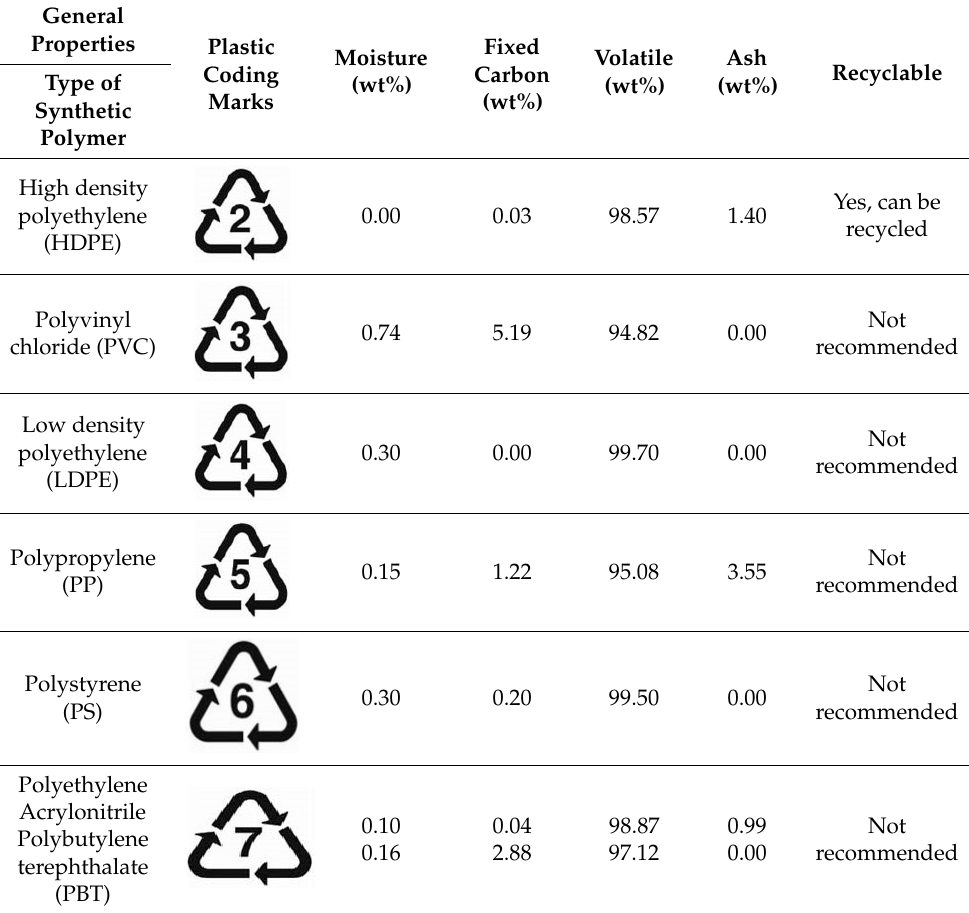
Table 3. Proximate analysis for plastics [46,47,50–52].